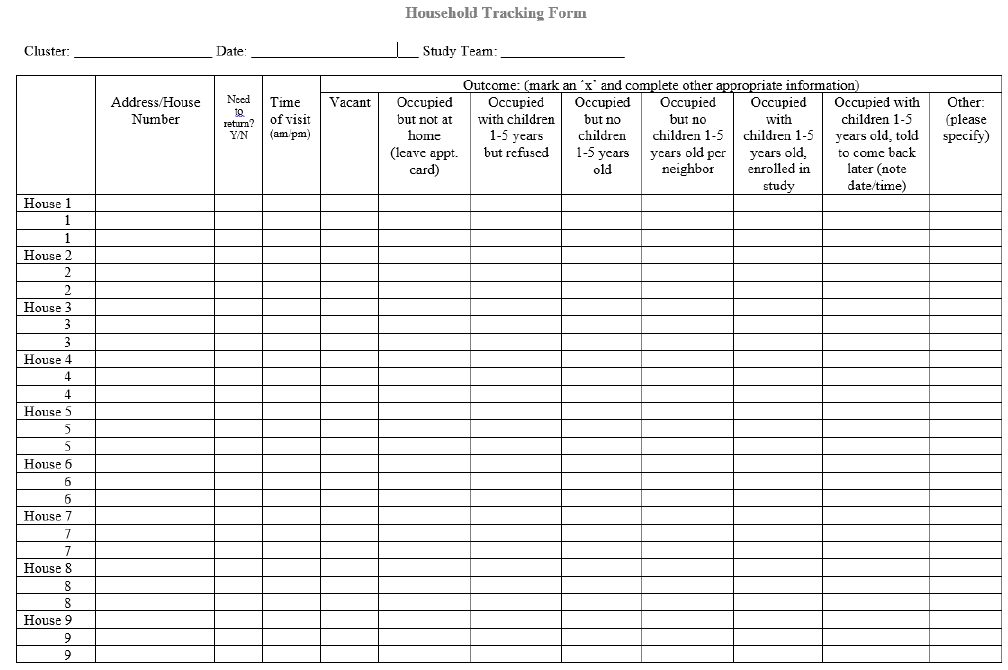
Figure A1: Example daily supervisor control form. Figure A1. Example daily supervisor control